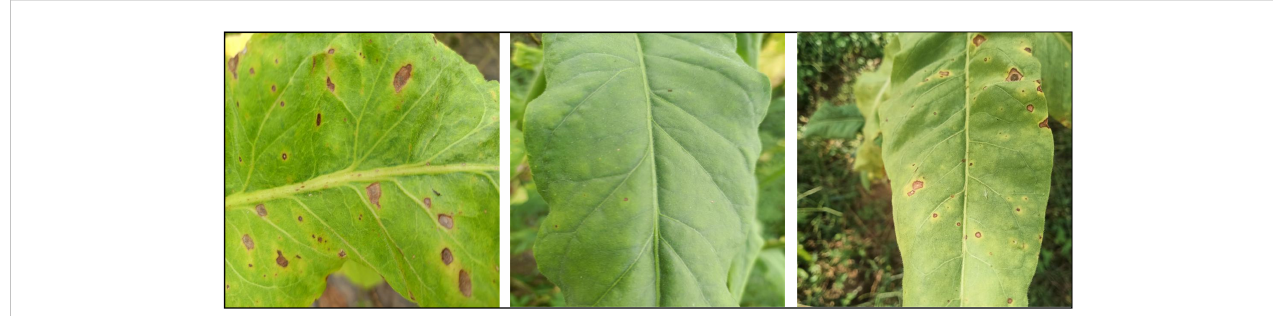
FIGURE 1 Examples of material that was collected for the dataset. Images of leaves of the tobacco plant ( Nicotiana tabacum L.) affected by tobacco brown spot disease were used to compile the dataset that was used in this study.